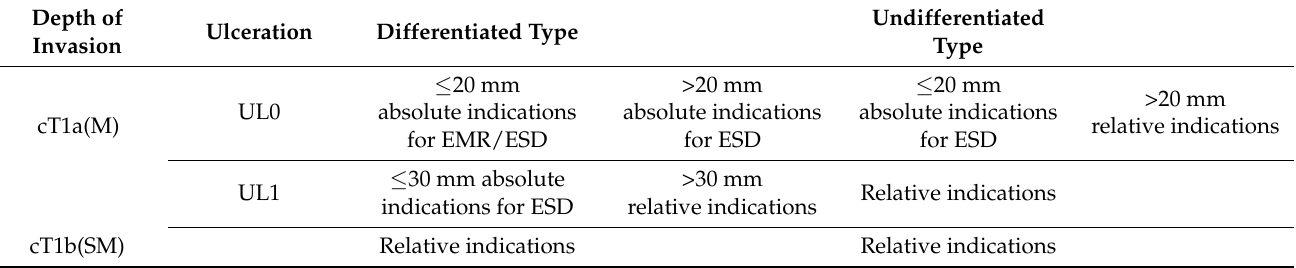
Table 3. Adapted from the guidelines for EMR and ESD of EGC [55].